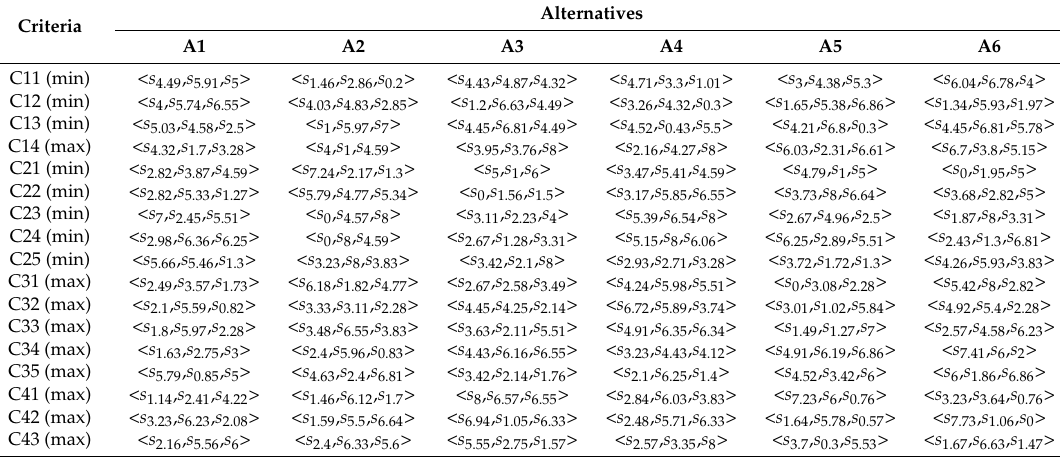
Table 6. Aggregated normalized initial matrix of